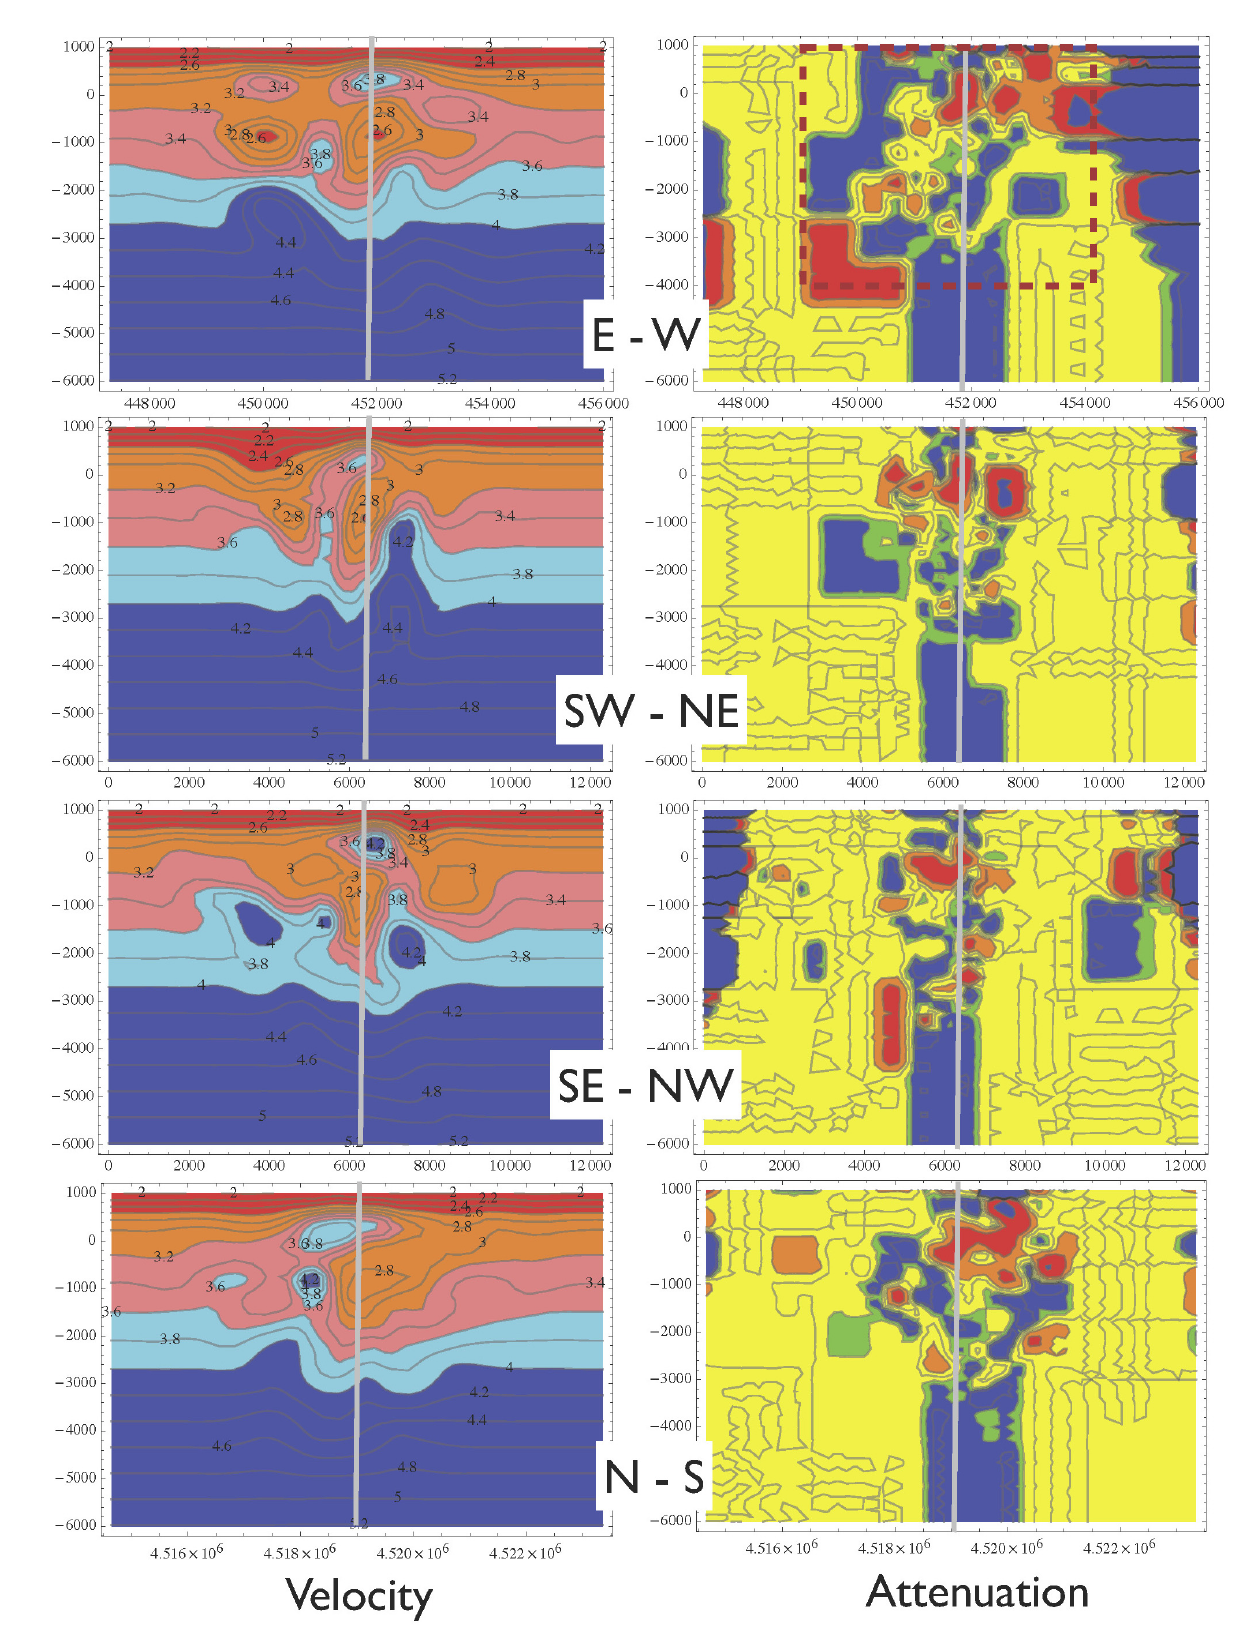
Figure 4. N-S, E-W, NE-SE, NW-SE sections in velocity (left panels) and differential attenuation. Color scale is the same as in Figures 1a and 3a. Isoline values for velocity (km/s) are reported in the left panels. Grey vertical lines indicate the intersection among the section 3-D planes depicted in Figures 1 and 3, which roughly corresponds with the crater axis. The shaded rectangle in the first upper-right panel shows the volume effectively resolved by attenuation